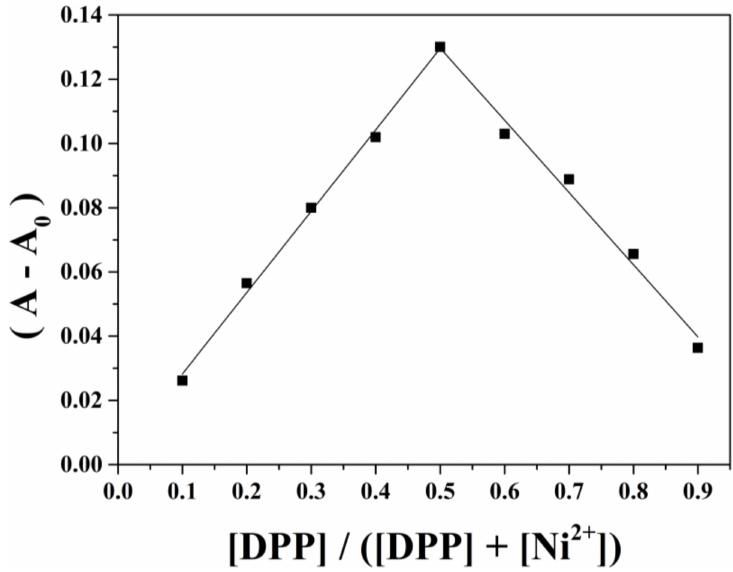
Figure 3. Job plot for DPP with Ni 2+ at 550